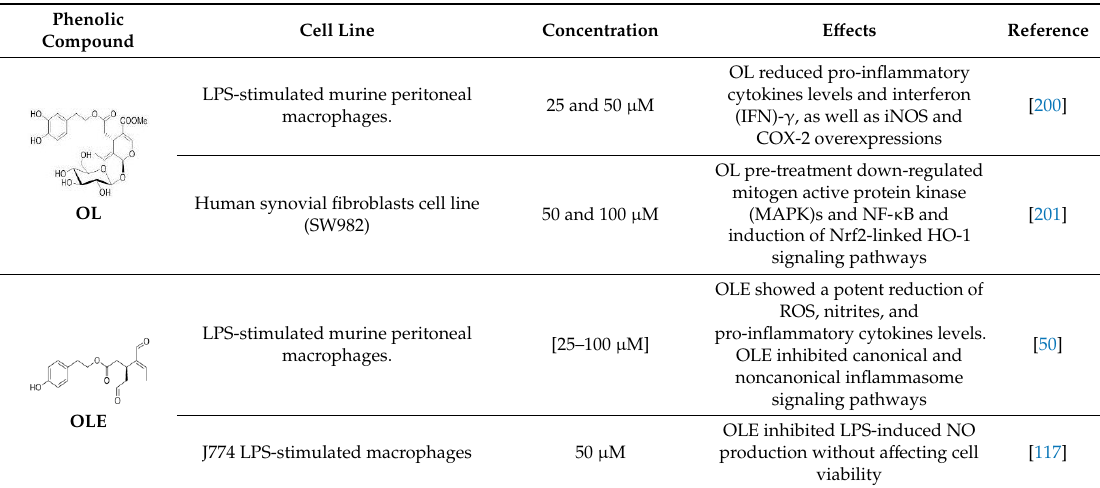
Table 10. Effective mechanisms and concentrations of bioactive secoiridoids from the olive tree in in vivo models and clinical trials of immunoinflammatory diseases.